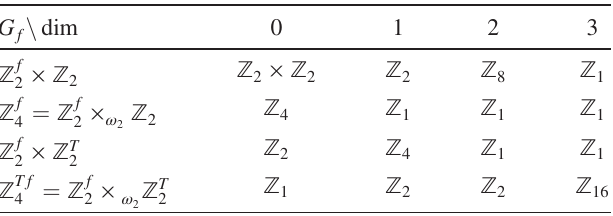
TABLE VI. Classification of FSPT phases with G different choices of s 1 and ω 2